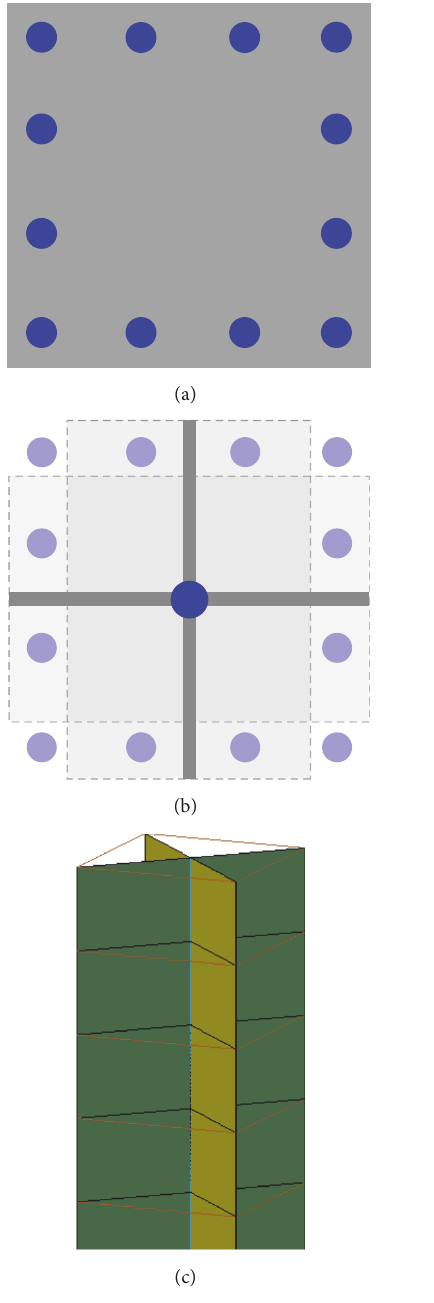
Figure 6: Column for structural finite element model: (a) real geometry of column section, (b) sketch of crossed shells, each with its corresponding virtual thickness, and with nine longitudinal bars overlapped at the column axis and their virtual position with geometrical offset, and (c) detail of model mesh.